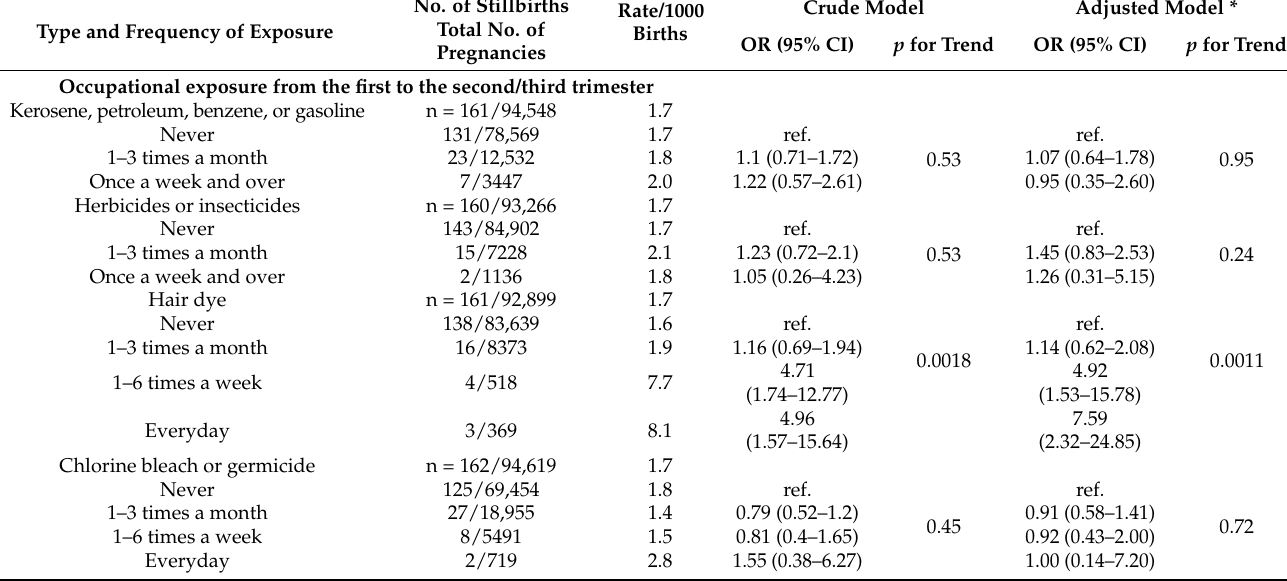
Table 3. Adjusted odds ratios for the occurrence of stillbirths for occupational exposures from the first to the second/ third